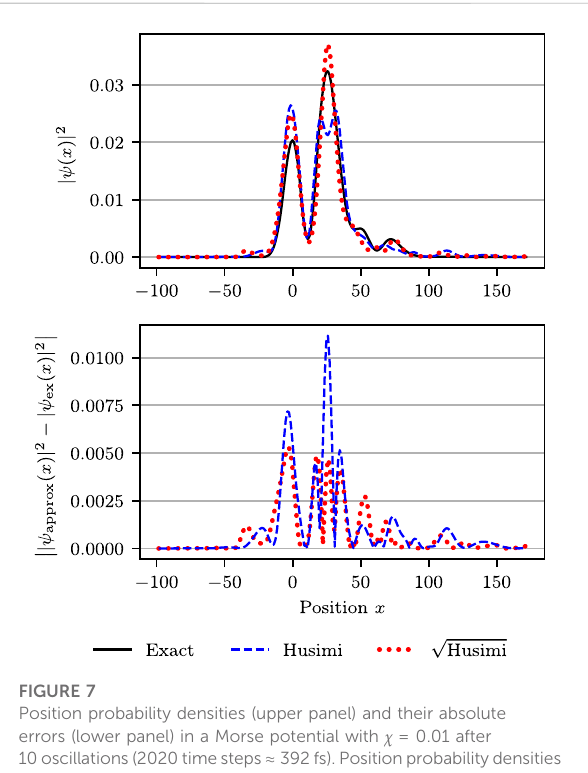
FIGURE 6 SameasFigure5,exceptthattheanharmonicityparameterofthe Morse potential was increased to χ = 0.01.